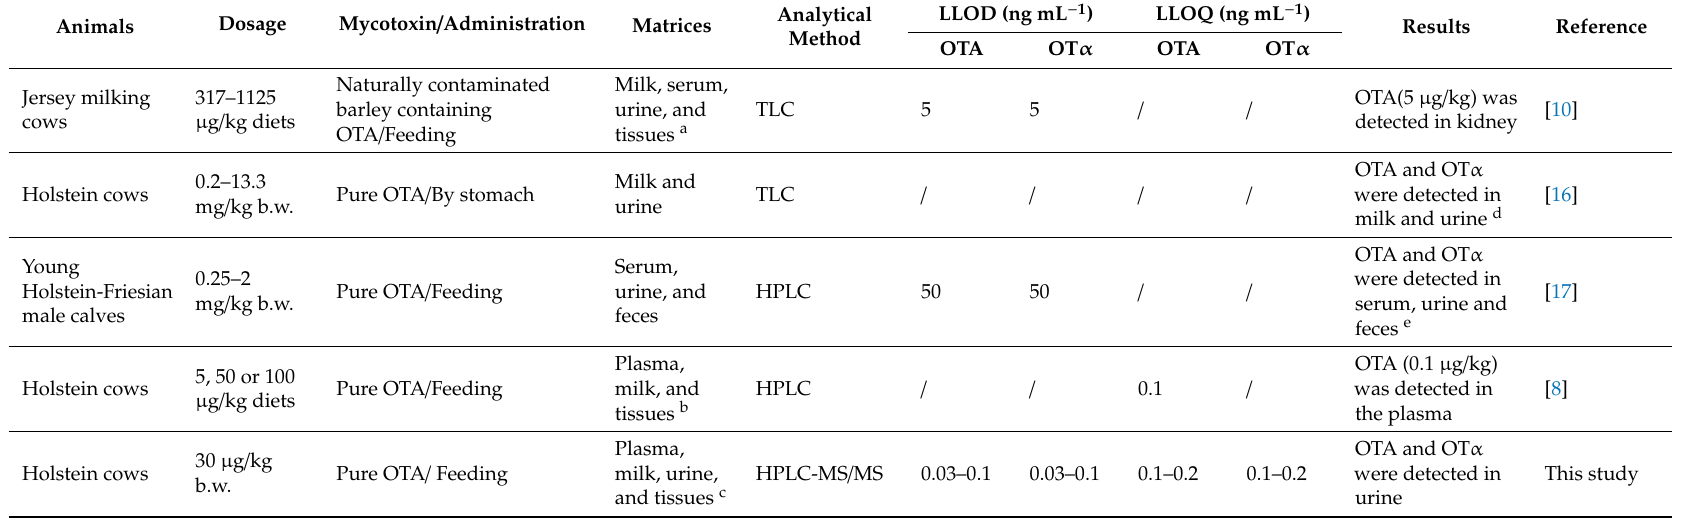
Table 5. Comparison of previous studies for the determination of ochratoxin A (OTA) and ochratoxin α (OT α ) in di ff erent biosamples from